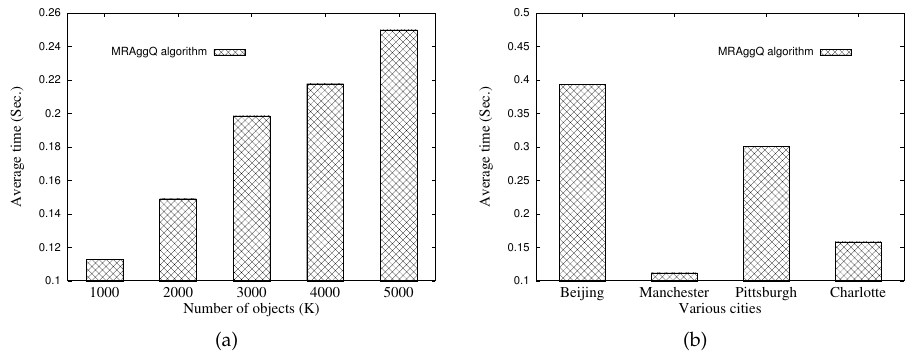
Figure 9. Effect of the number of objects. ( a ) Uniform dataset; ( b ) Real dataset.